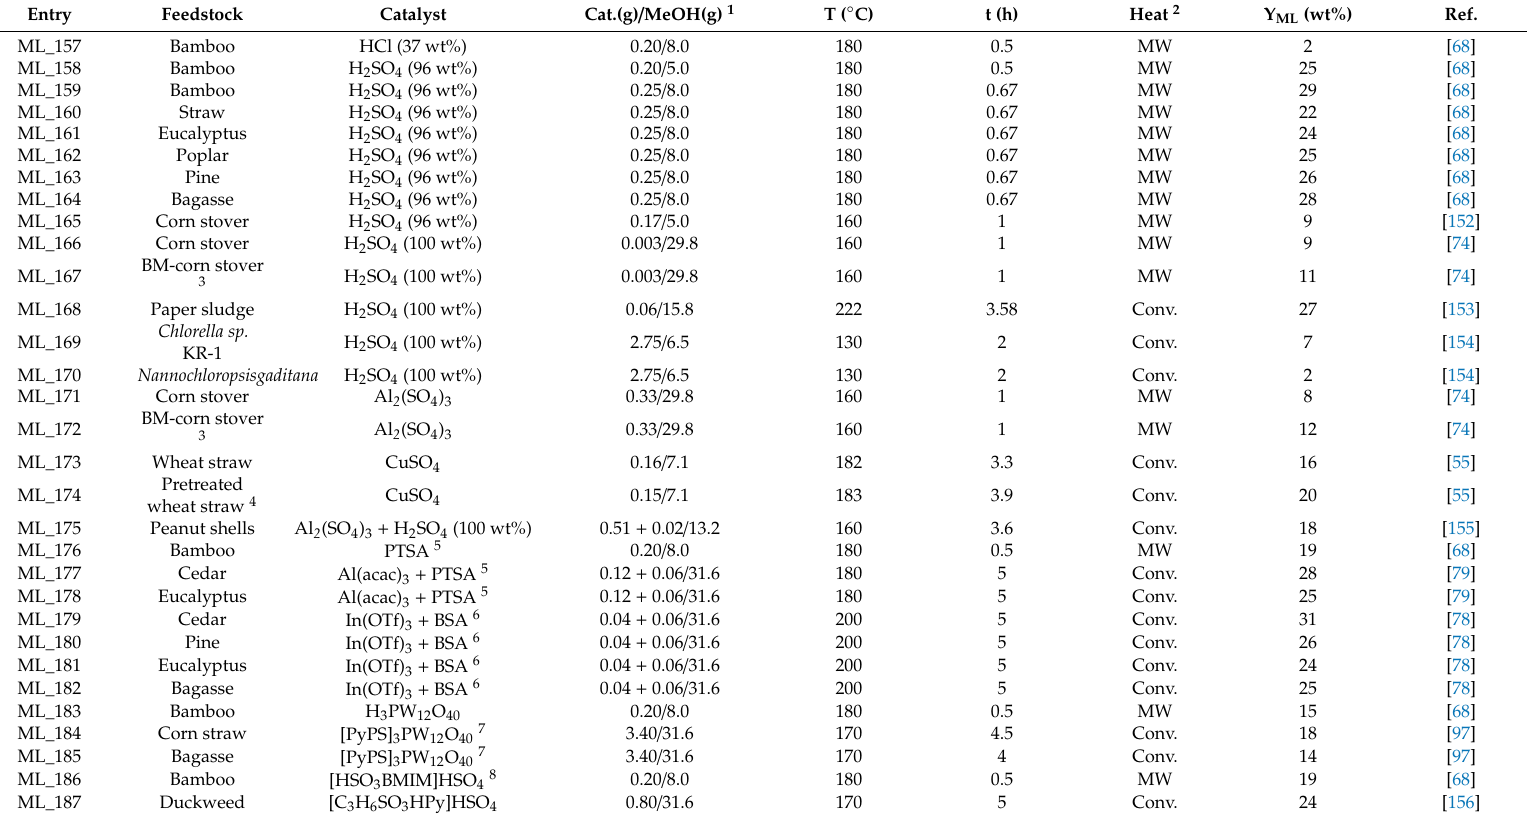
Table 15. Available catalysts for the ML production from real